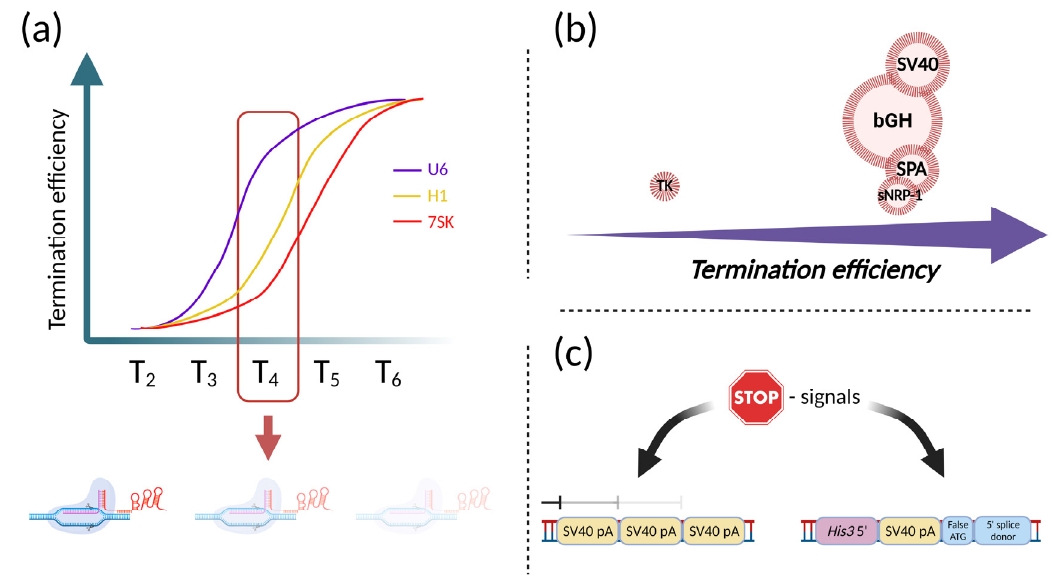
Figure 2. Picking a right transcriptional terminator. ( a ) Schematic representation of termination efficiencies for different Pol III promoters. Each curve represents the dependency of termination on the length of the poly-(T) sequence (T n ). The red frame indicates critical for multiplexing T 4 -stretch, naturally presented in Cas9 sgRNA. Faded Cas9/sgRNA/DNA complex represents consequences of the T 4 -stretch inside Cas9 sgRNA on multiplex transcription from Pol III promoter; ( b ) Schematic comparison of the termination efficiencies from different termination signals. The diameter of the circle represents the relative size of the terminators. The termination efficiency was equally high for most of the termination signals, clearly except for TK; ( c ) STOP-signal variants. Left—STOP signal made with the aim to maximize termination efficiency, combining three SV40 poly(A) signals. Right—STOP signal which not only terminates transcription but also prevents translation. This STOP signal consists of a C-terminal sequence of the yeast His3 gene, SV40 polyadenylation signal, and a false translation initiation signal, combined with a 5 ′ splice donor site. Figure was created using BioRender.com.